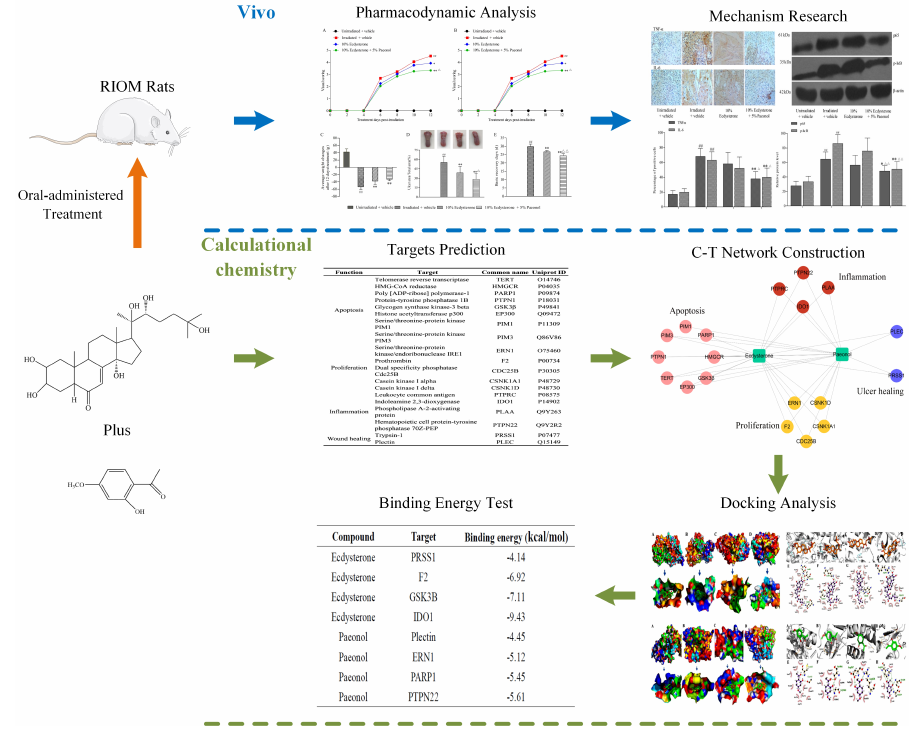
Figure 2. Research scheme for therapeutic e ff ect and possible underlying mechanisms